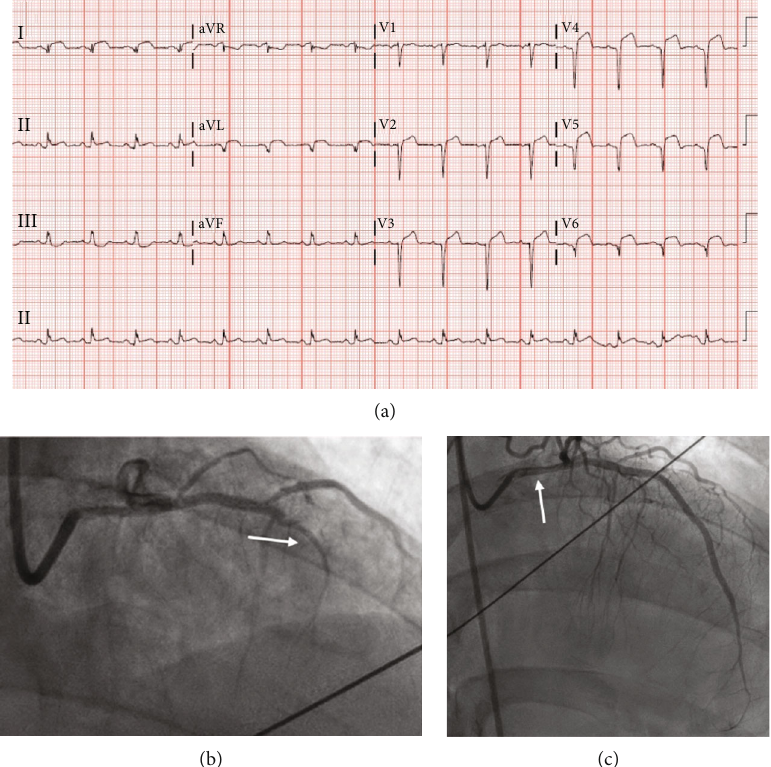
Figure 2: ECG on admission and LHC fi ndings. (a) ECG showing ST elevations in anterolateral leads. (b) Initial coronary angiography with arrow showing occluded LAD. (c) Coronary angiography after PCI with arrow showing coronary vasospasm in distal